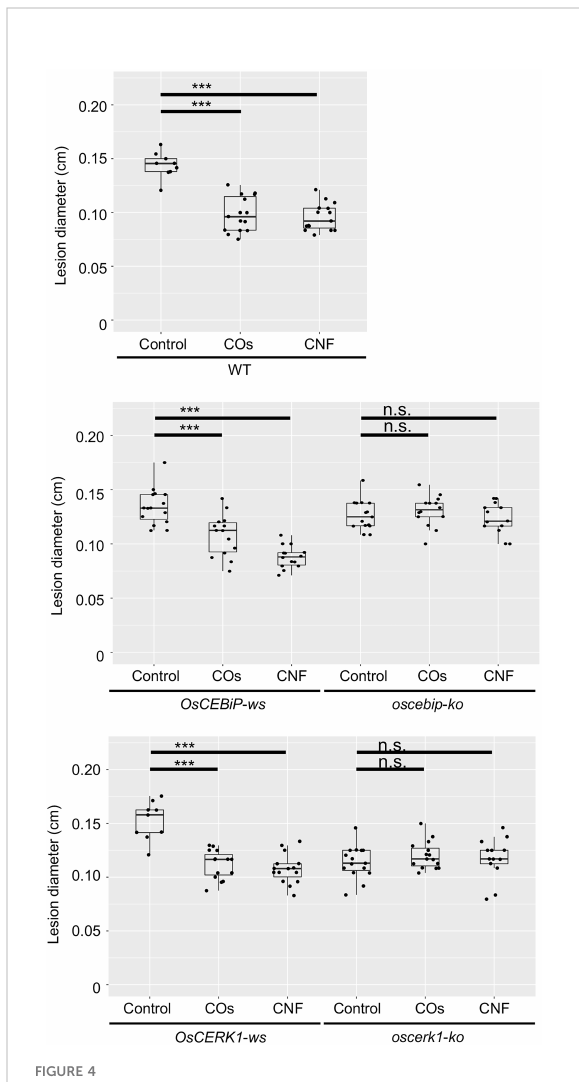
FIGURE 4 Chitins induce systemic disease resistance in LysM-receptor mutants. Lesion diameters upon B oryzae inoculation in wild- type plants (WT), wild-type siblings ( ws ), and knockout ( ko ) mutants of OsCERK1 or OsCEBiP , conducted as in Figure 1. Seedlings were grown on 0.01% (w/v) COs- or CNF-containing soils. Representative results from three independent experiments are shown. Asterisks indicate signi fi cant differences by Student ’ s test (*** p < 0.001, n.s., not signi fi cant, n >